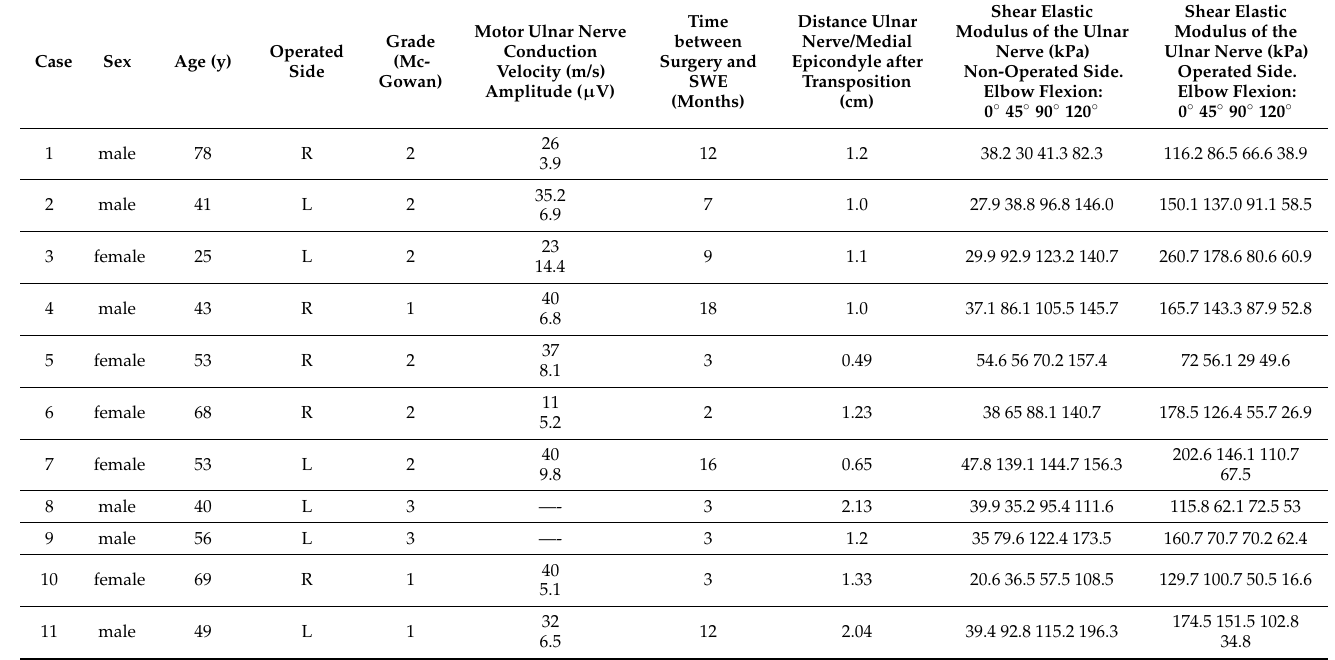
Table 1. Patient demographics and clinical data, ENMG and imaging follow-up, and outcome.